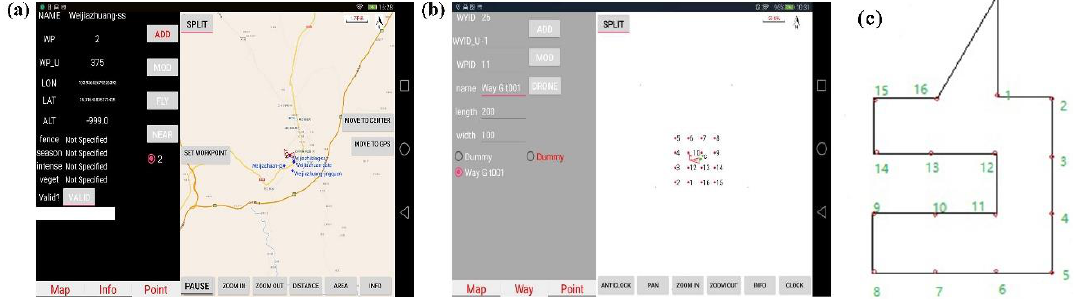
Figure 2. Operation interfaces of unmanned aerial vehicle remote sensing (UAVRS) applications: ( a ) waypoint parameter setting in the FragMAP Locator APP which included the waypoint name, working point number, latitude, longitude, altitude, flight time, and weather conditions during the flight; ( b ) flight route setting in the FragMAP Monitor APP which provided functions of adjusting the space position of the route, setting the flight height, speed, overlap, and photo time of the route, and collecting the position information of each photo; and ( c ) the flight path.